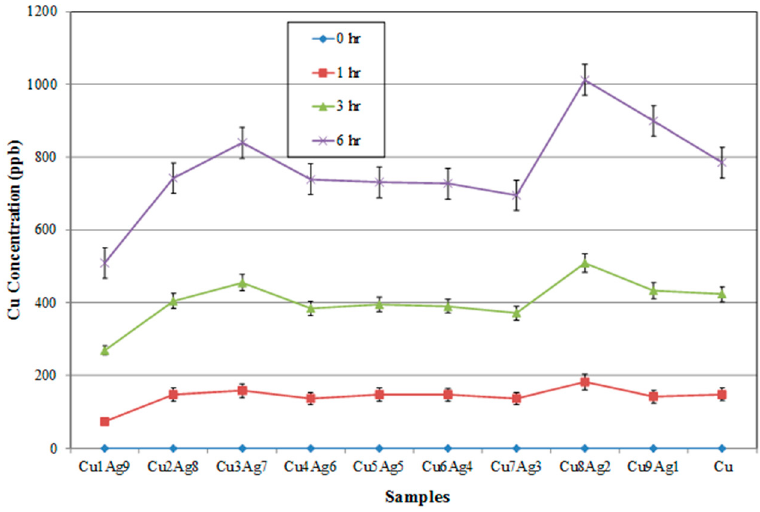
Figure 8. Cu + concentrations of Cu–Ag alloy films immersed in a buffer solution (pH = 7) as a function of time.